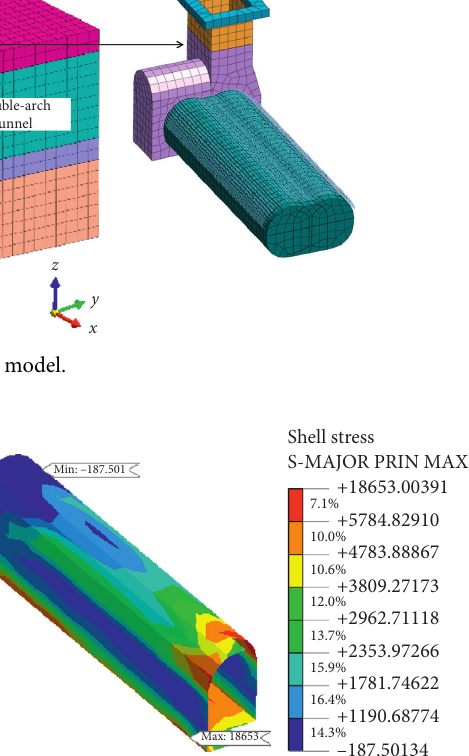
Figure 8: Maximum principal stress of initial